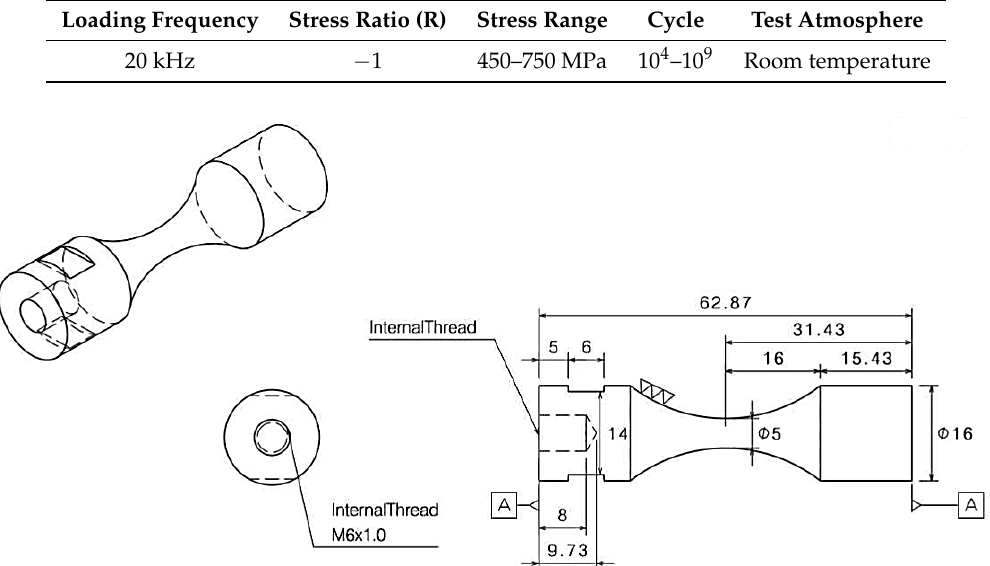
Table 1. Conditions of ultrasonic fatigue test.